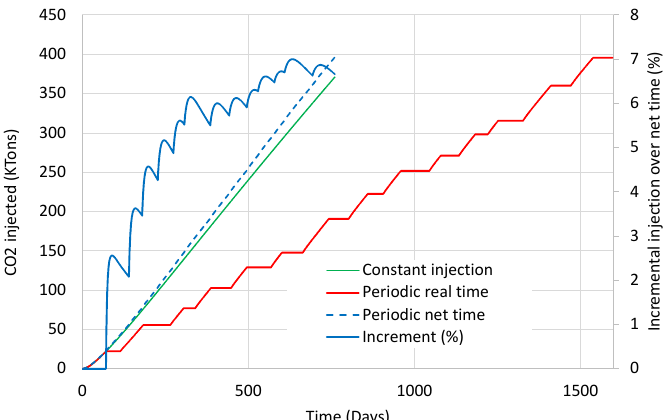
Figure 25. Up-flank injection with varying period lengths. The periodic injection shows around 6.5% more CO 2 injected after two years net injection time compared to continuous injection.